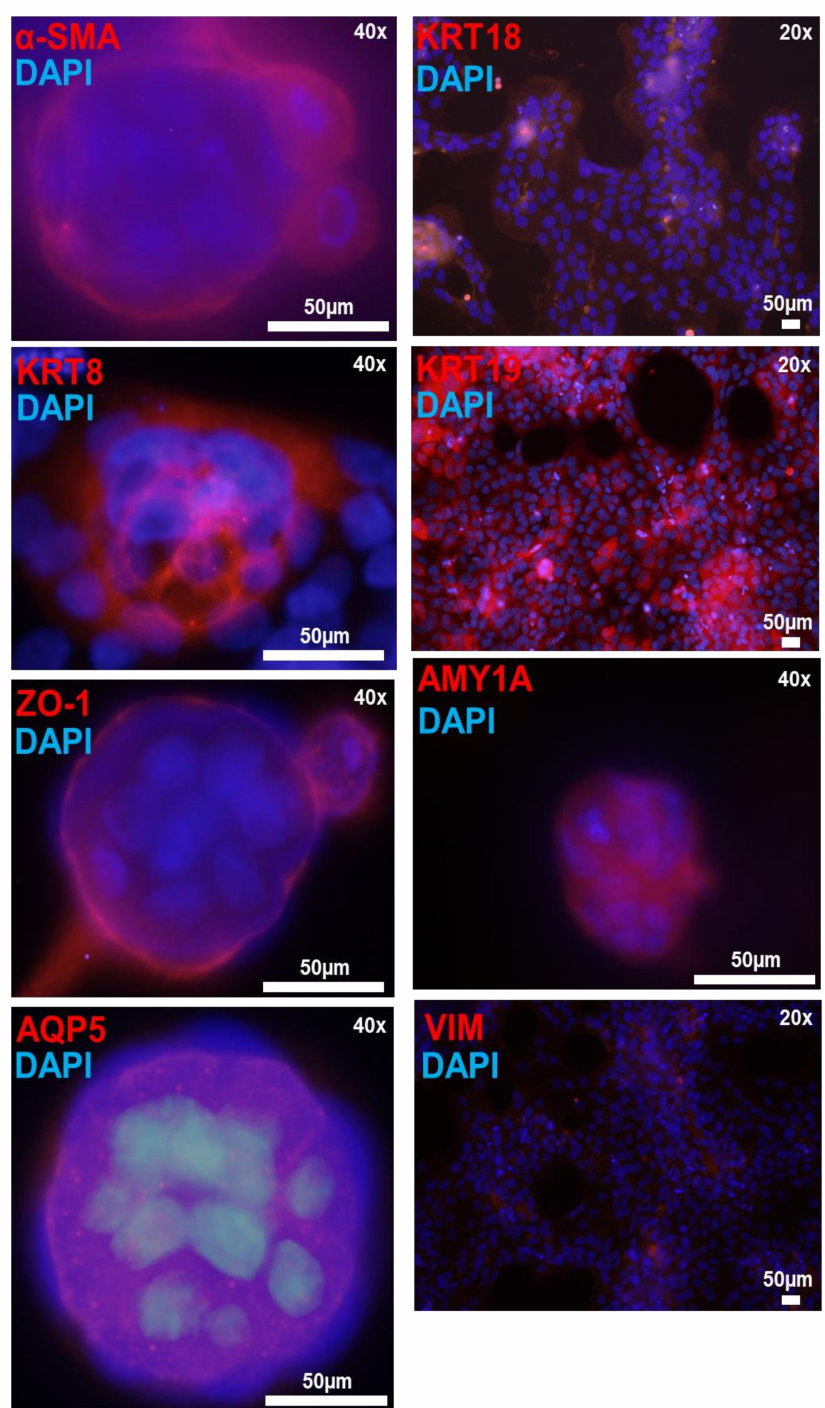
Figure 7. Immunofluorescence detection of salivary epithelium markers in matrigel cultured iSGEC-nSS2 cells. Legend. Detection of salivary epithelium markers ( red ) by immunofluorescence in matrigel cultures of iSGEC-nSS2 p-80 after 7 days. Spheroids expressed acinar cell markers (AQP5, AMY1A), tight-junction protein (ZO-1), and had clearly defined myoepithelial cells ( α -SMA). Cells growing on the surface of the matrigel and spheroids expressed salivary epithelial markers KRT8, KRT18, and KRT19 proteins. Vimentin was expressed low and sparsely among cells and did not indicate regular staining patters. Scale bar represents 50 µ m. DNA ( blue ) is highlighted with